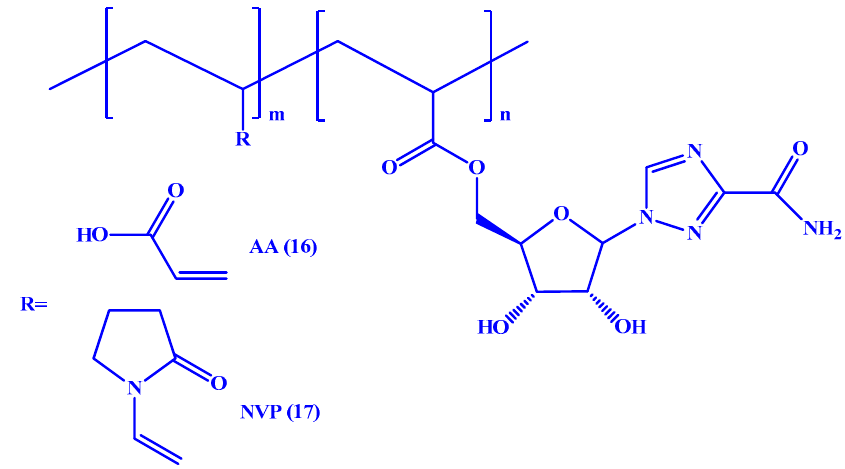
Figure 9. Chemical structures of RBV-AA ( 16 ) and RBV-NVP ( 17 ).